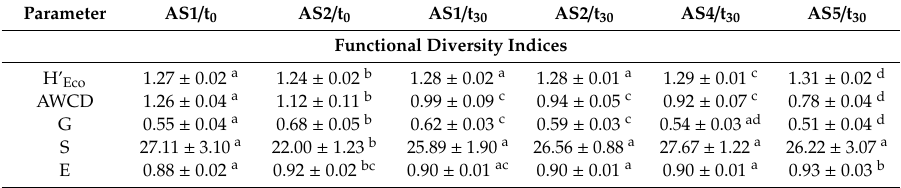
Figure 5. Usage of carbon substrate guilds by the microorganisms from different experimental conditions (assays AS1, AS2, AS4, and AS5) during the experimental period (30 days). The different letters (a, b, c, d, e) indicate significant differences ( p < 0.05, LSD test) in the usage of substrates guilds considering different experimental conditions and/or sampling day. Table 3. The functional diversity indices for the AS in di ff erent experimental